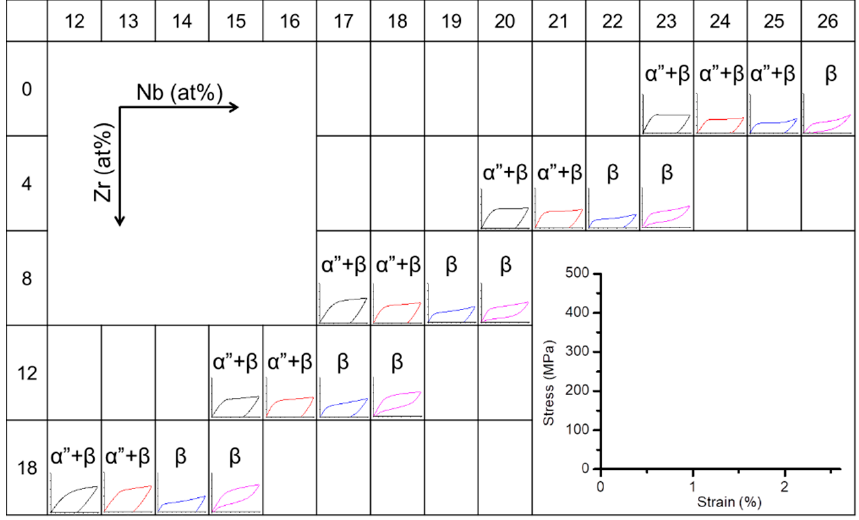
Figure 7. Stress-strain curves of Ti–40Nb and Ti–40Nb–(4, 8, 12) Zr alloys obtained at room temperature.